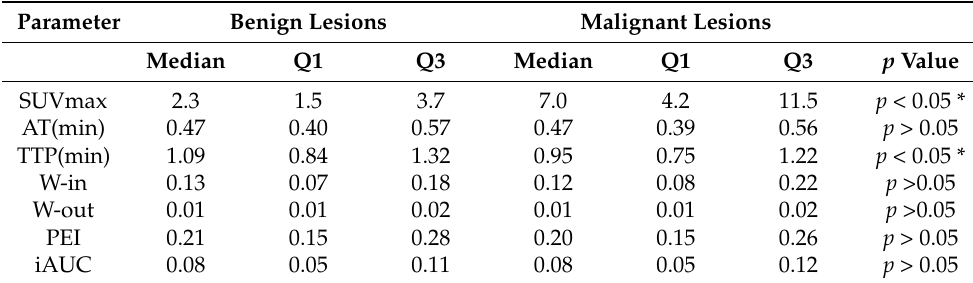
Table 1. Comparison of parameters between benign and malignant lesions. Parameter Benign Lesions Malignant Lesions Median